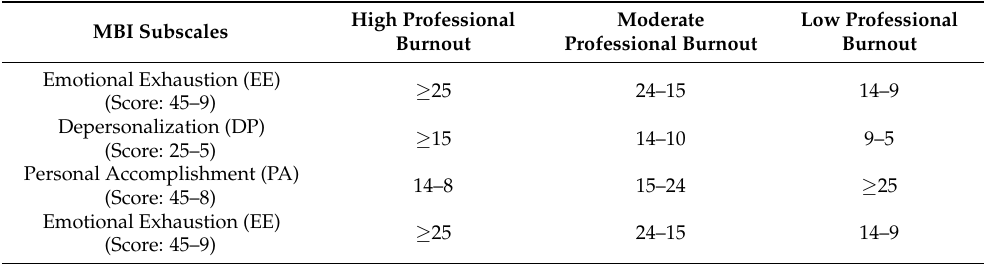
Table 1. The adjusted normative scores for the Maslach Burnout Inventory subscales for the present study.